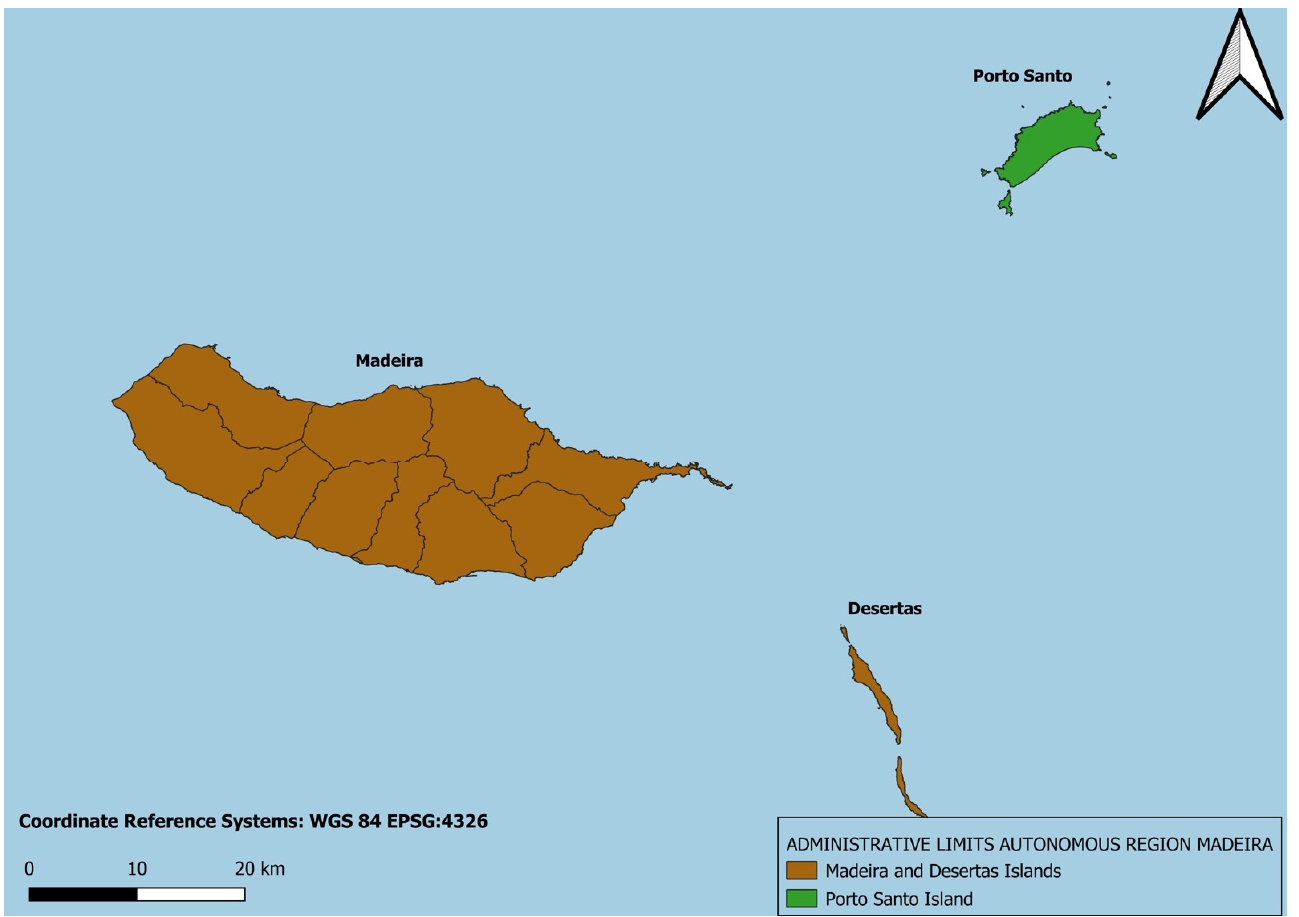
Figure 1. Archipelago of Madeira—Porto Santo Island. (Source: Authors by ESRI ArcGIS, 2020).